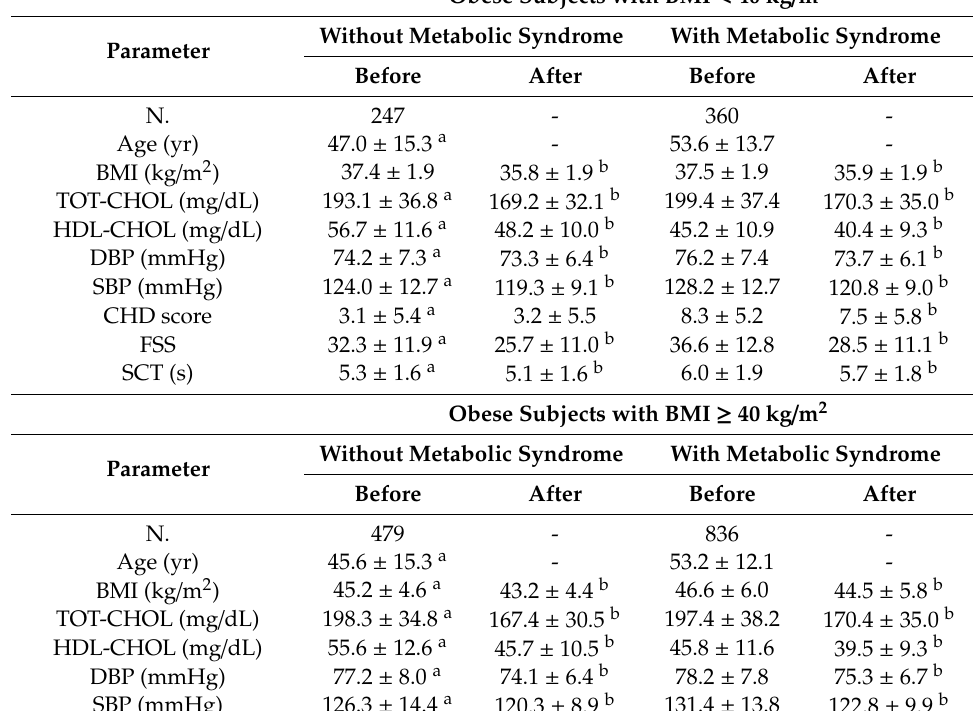
Table 3. Demographic, biochemical, and clinical characteristics of obese subjects with BMI < and ≥ 40 kg / m 2 (obesity of degree 1–2 and degree 3, respectively), recruited in the study, subdivided into the two groups with or without metabolic syndrome, who underwent the 3-week